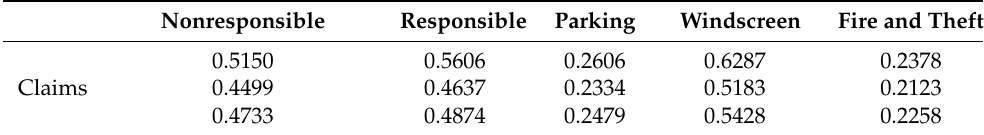
Table 4. Correlation between empirical frequencies associated with the total claims number and each response variables (first row) and the correlation derived by means of the basic model (second row) and zero-inflated model (third